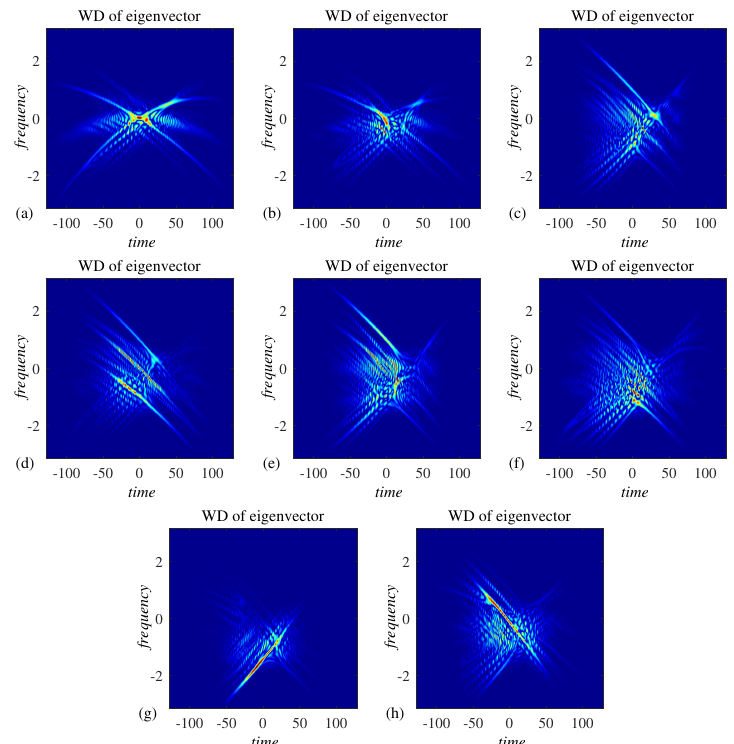
Figure 7. ( a – h ) Time-frequency representations of eigenvectors corresponding to the largest eight eigenvalues of autocorrelation matrix R of the signal from Example 2. Each eigenvector represents a linear combination of non-stationary components with polynomial frequency modulation.